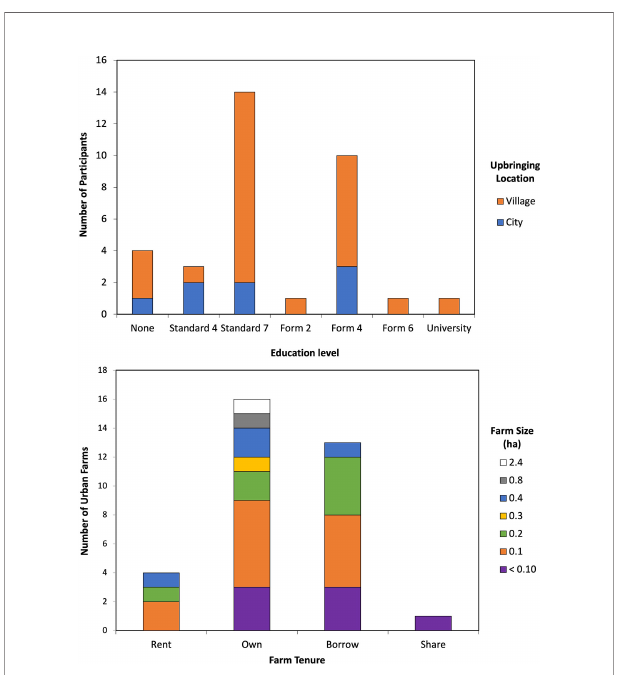
FIGURE 4 | (Top) Distribution of urban farmers ’ education level in relation to their upbringing location. More respondents reported upbringing in the village districts than city upbringing and a majority reported completing some form of formal education. (Bottom) Distribution of urban farm tenure corresponding to the urban farm size. Most urban farms are owned, though many urban farms are also borrowed. Farm sizes vary with ownership, though most farms are 0.2 ha or less for both owned and borrowed